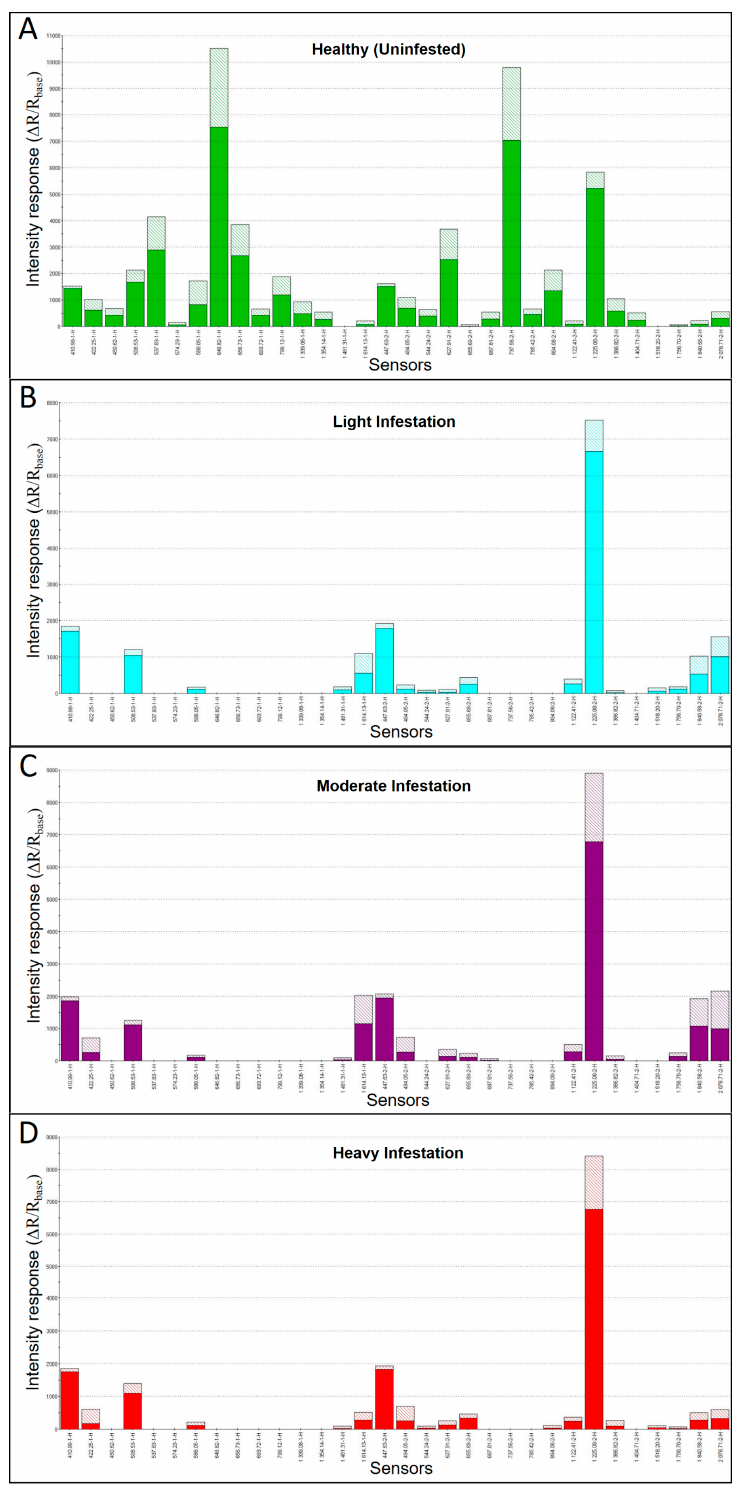
Figure 2. Electronic-nose smellprint signatures of VOC-metabolites from green ash sapwood cores with di ff erent levels of EAB infestation. ( A ) Smellprint signature of healthy (uninfested) sapwood (decline rating 1); ( B ) Smellprint signature of sapwood with light EAB-infestation level (decline rating 2); ( C ) Smellprint signature of sapwood with moderate EAB-infestation level (decline rating 3); ( D ) Smellprint signature of sapwood with heavy EAB-infestation level (decline rating 4). Shaded areas indicate one standard deviation from the